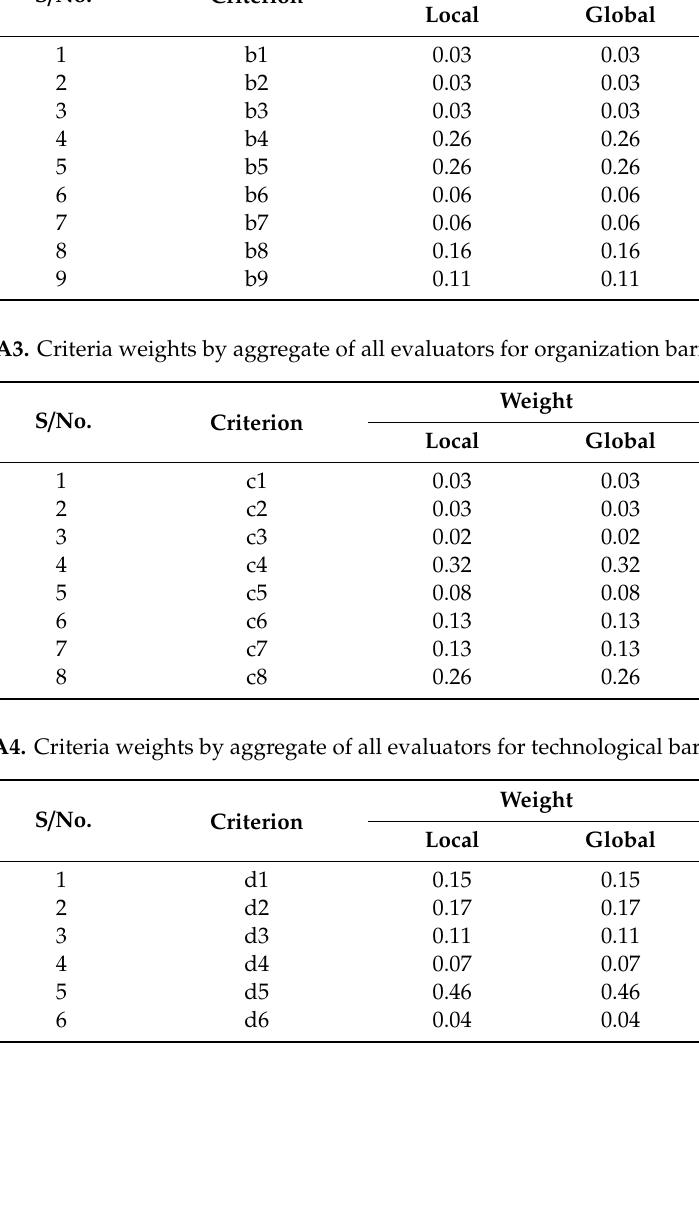
Table A2. Criteria weights by aggregate of all evaluators for individual barriers. S / No.